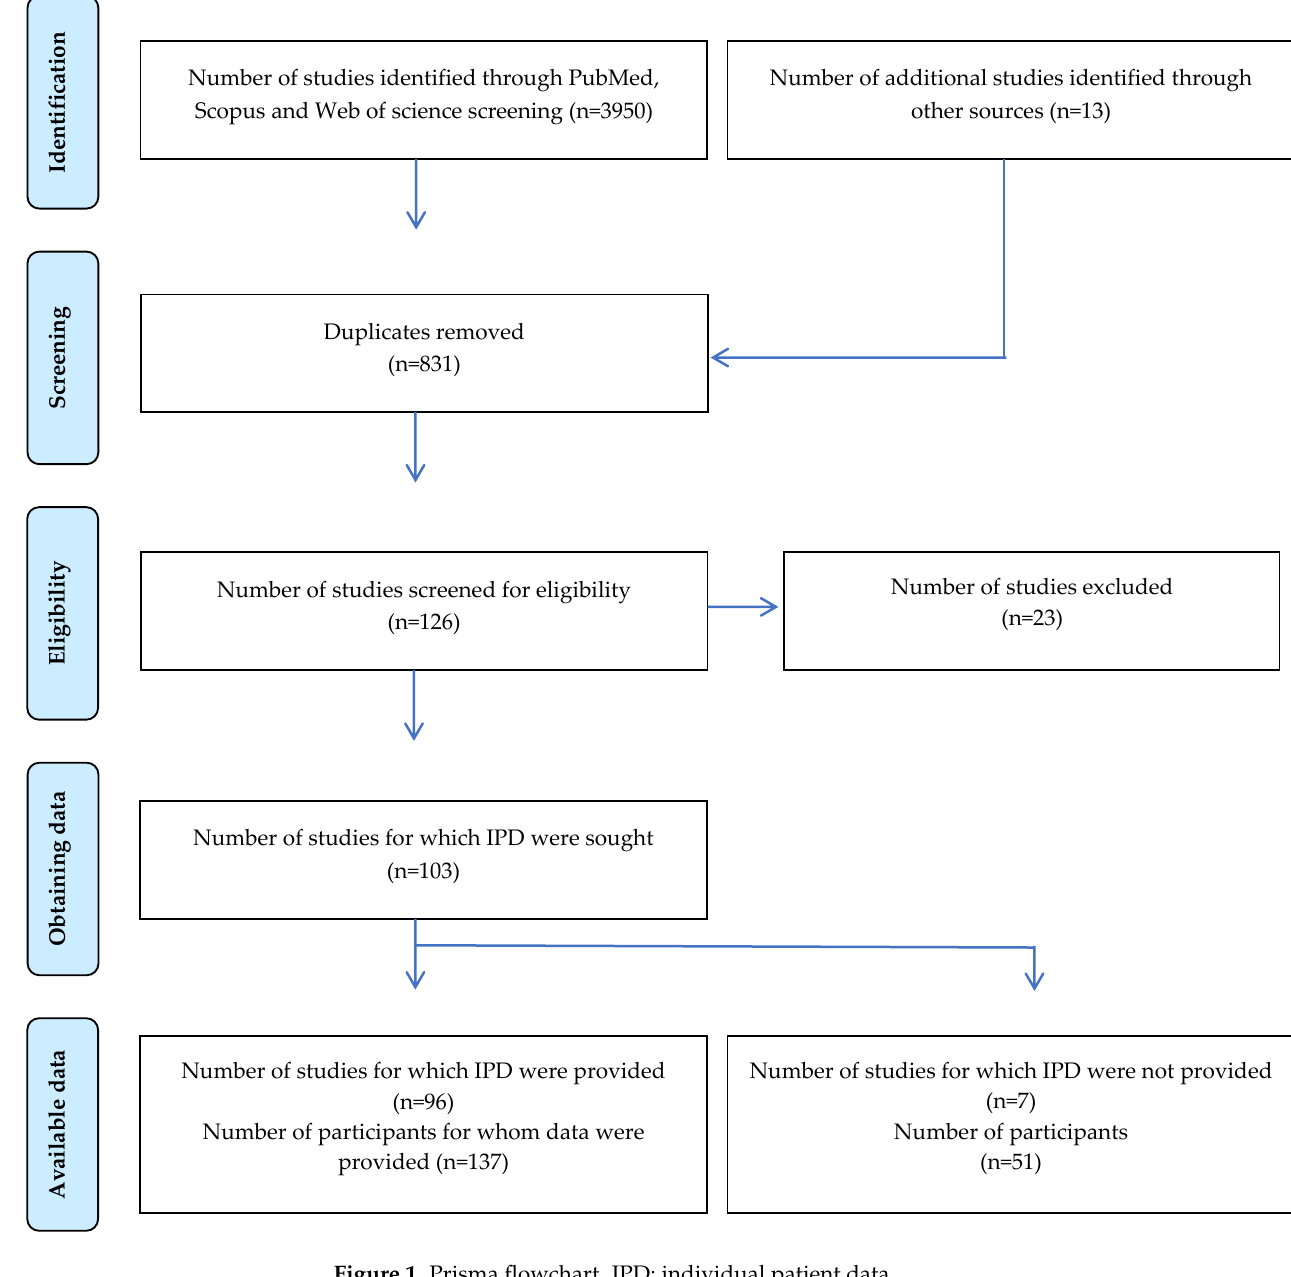
Figure 1. Prisma flowchart. IPD: individual patient